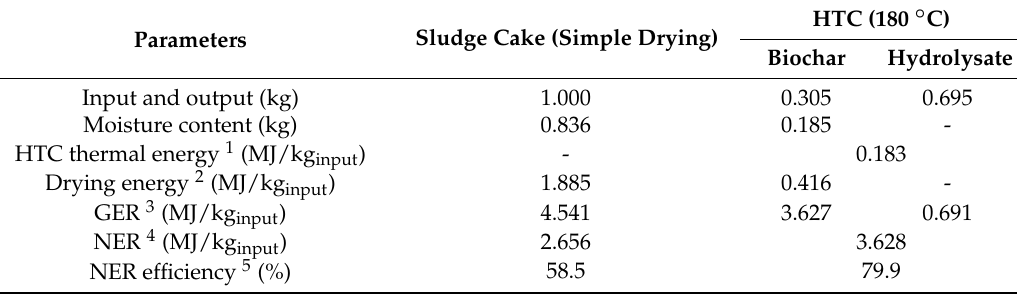
Table 7. Net energy recovery efficiency of sludge cakes in the poultry slaughterhouse with the HTC